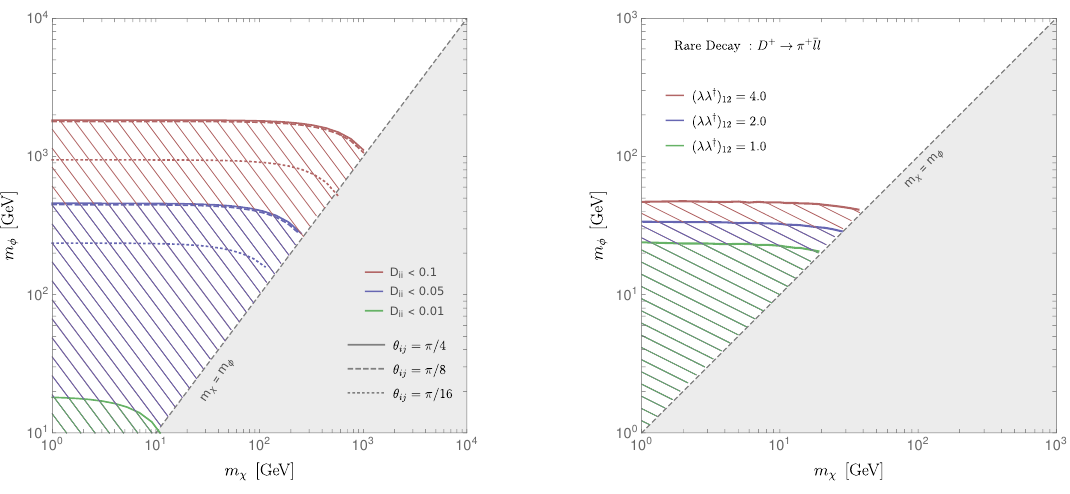
Figure 3 . Excluded regions (hatched) for which the value of (cid:1) M from DMFV diagrams exceeds the +1 (cid:27) contour of the experimental result (left). The bounds are the most constraining possible given the limits on D , and can be made arbitrarily small by adjusting the values (for example ii with equal values D = D ). The exclusions from C 0 9 < 1 : 3 varying ( (cid:21)(cid:21) y ) 12 ii j j